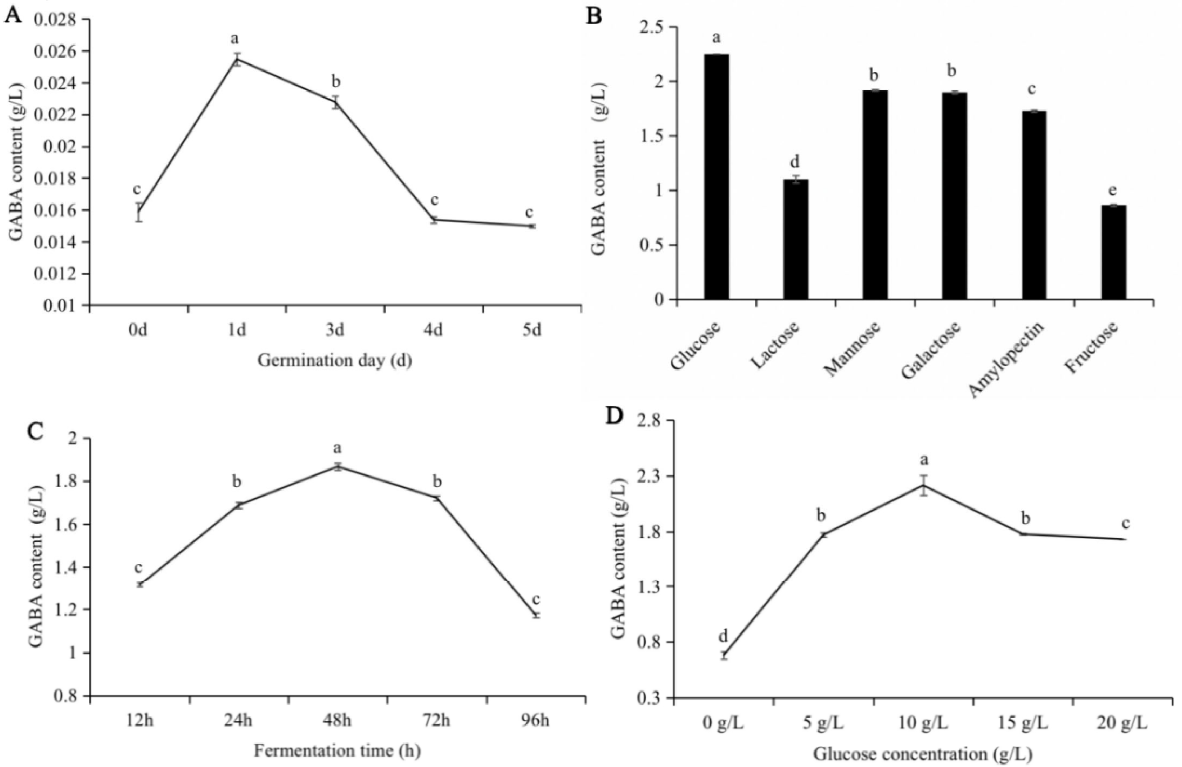
Figure 2. Effect of different conditions on the production of GABA by Lb. brevis 145 in soybean sprout yogurt. ( A ) represents germination day; ( B ) represents carbon source types; ( C ) represents fermentation time; ( D ) represents glucose concentration. Means and standard deviations of triplicate experimental data were represented by the values and error bars. a, b, c, d, and e in the figure represent different product were significant difference in various